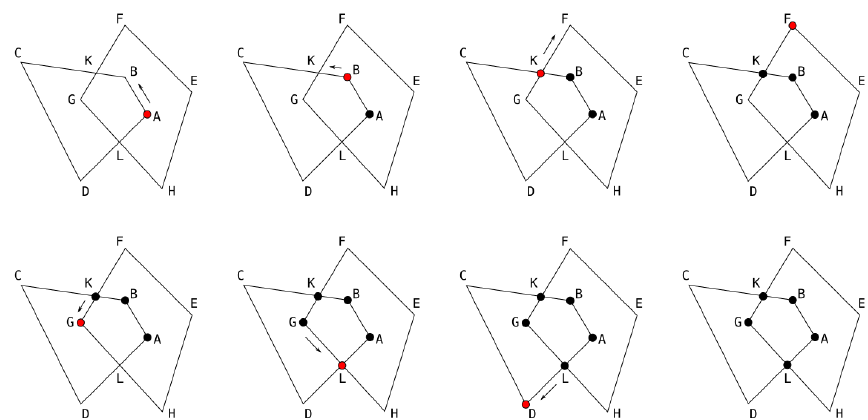
Figure 3. Steps in determining the intersection U of cells ABCD and EFGH. The starting point is a vertex interior to the other cell, here denoted by A. The first examined segment is AB, which contains no intersections (step 1) so it is included in U as is. Along edge BC, intersection K is encountered (step 2), so segment BK is included in U , and we branch to edge KF of the other cell (step 3). However, vertex F is checked to be outside cell ABCD (step 4), so the search direction is reversed towards G (step 5). Another intersection is then found along edge GH, namely L (step 6), and after another direction reversal due to stepping outside again (step 7), the loop is completed by returning to A (step